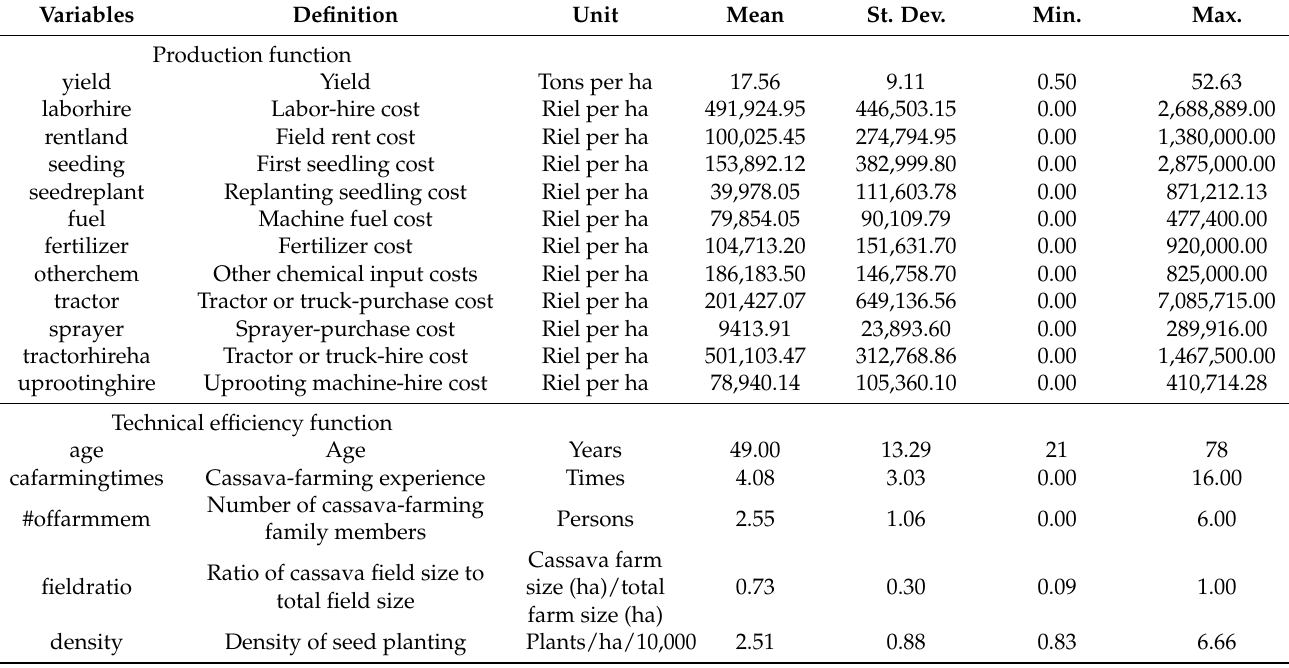
Table 1. Socio-economic characteristics of respondents in Battambang and Pailin